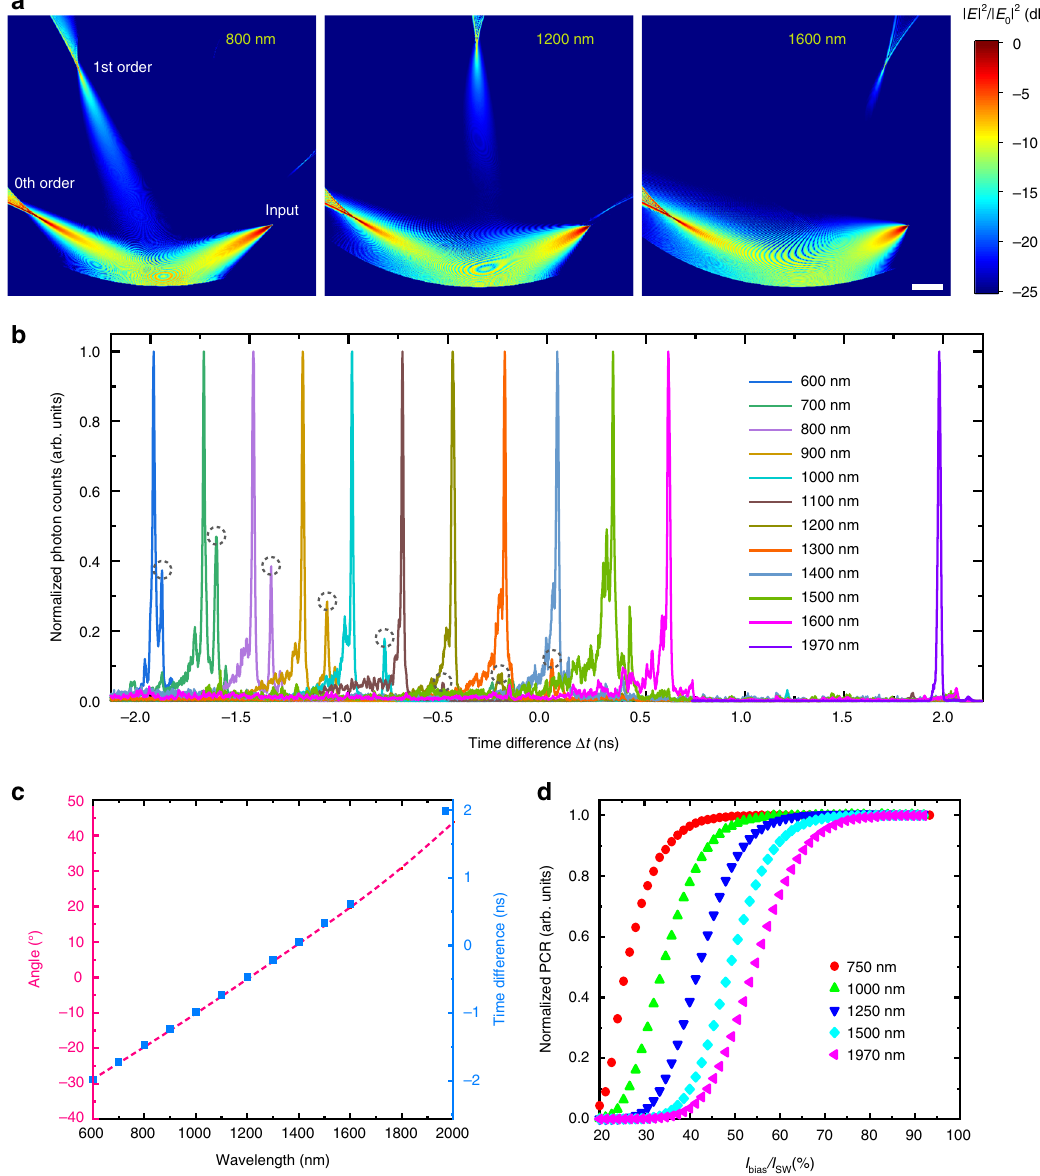
Fig. 3 Broadband device results. a Electric fi eld distribution of the device from 2.5-dimensional FDTD simulation results at different wavelengths. Scale bar, 100 µ m. b Normalized histogram of photon counts versus time difference Δ t measured for different wavelength photons from 600 nm to 1970 nm. The main peaks are from the TE modes while the minor peaks marked by the dashed circles are from TM modes. The histogram is recorded with the nanowire detector biased at 80% of its switching current I SW . c Comparison between experimentally measured Δ t and the diffraction angle extracted from the simulation results. d Normalized photon counting rates (PCR) measured as a function of the bias current relative to the switching current of the device I I bias / SW at wavelengths from 750 to 1970 nm. The complete saturation trend of the curves indicates a near-unity internal quantum ef nanowire detector over the whole spectrum. The histogram results are taken from Device C with double-nanowire detector, while the ef fi ciency curves are measured from Device B with single-nanowire structure for better comparison between different wavelengths (see Supplementary Note